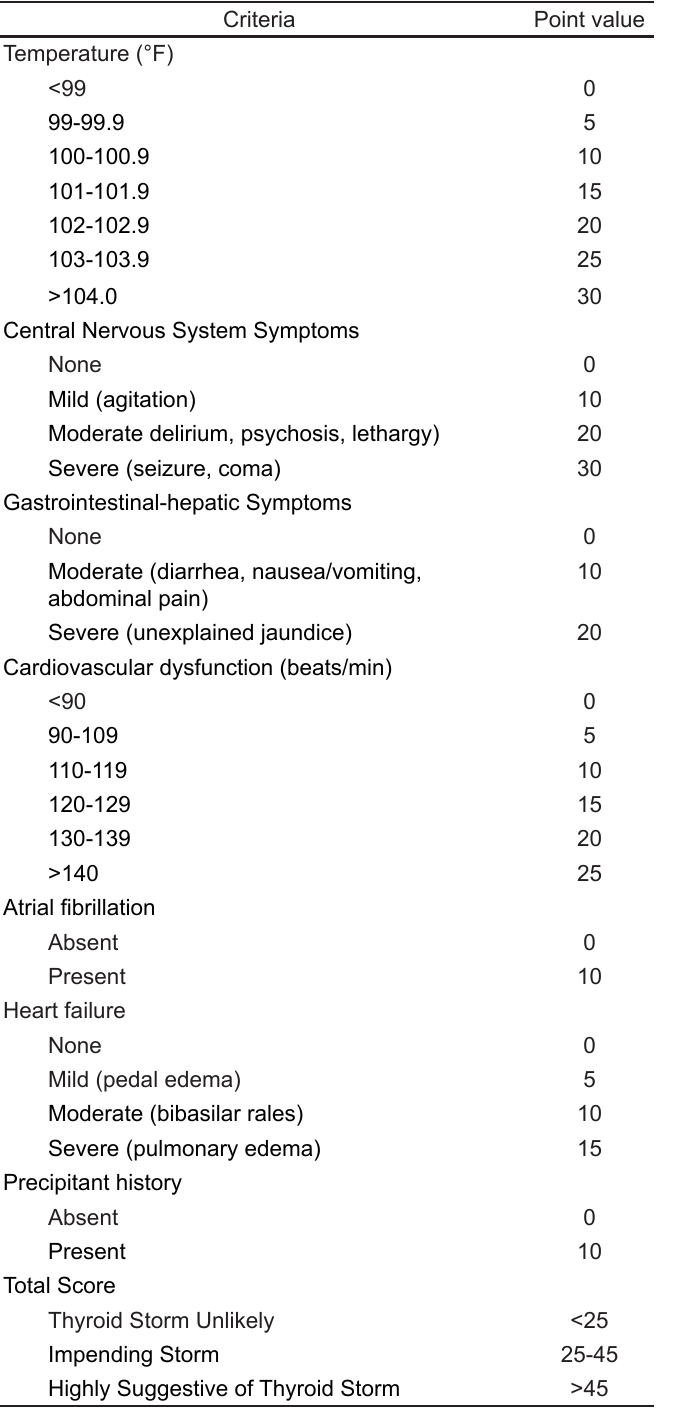
Table. The Burch-Wartofsky Point Scale is used as a clinical scoring system for hyperthyroid